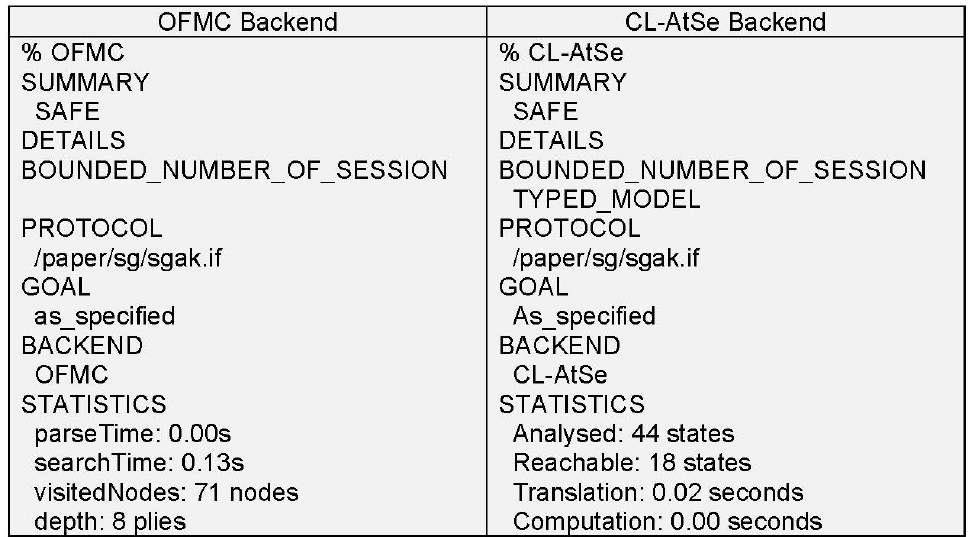
Figure 5. Output of the SPAN-AVISPA